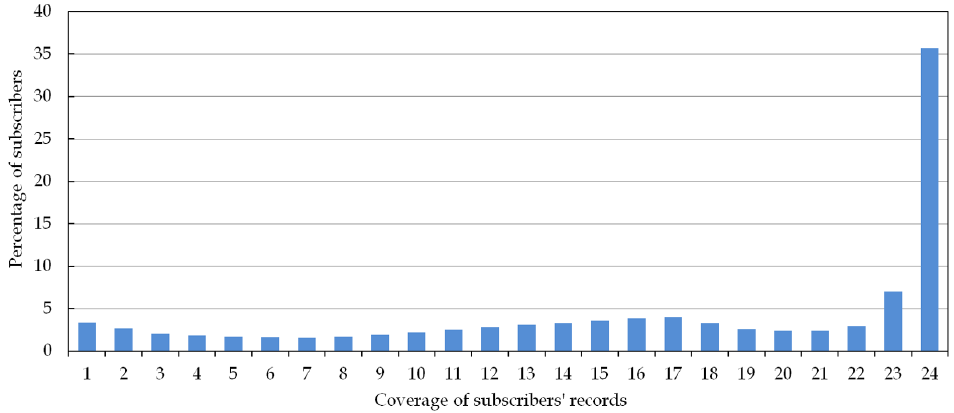
Figure 4. Temporal coverage of subscribers’ records.